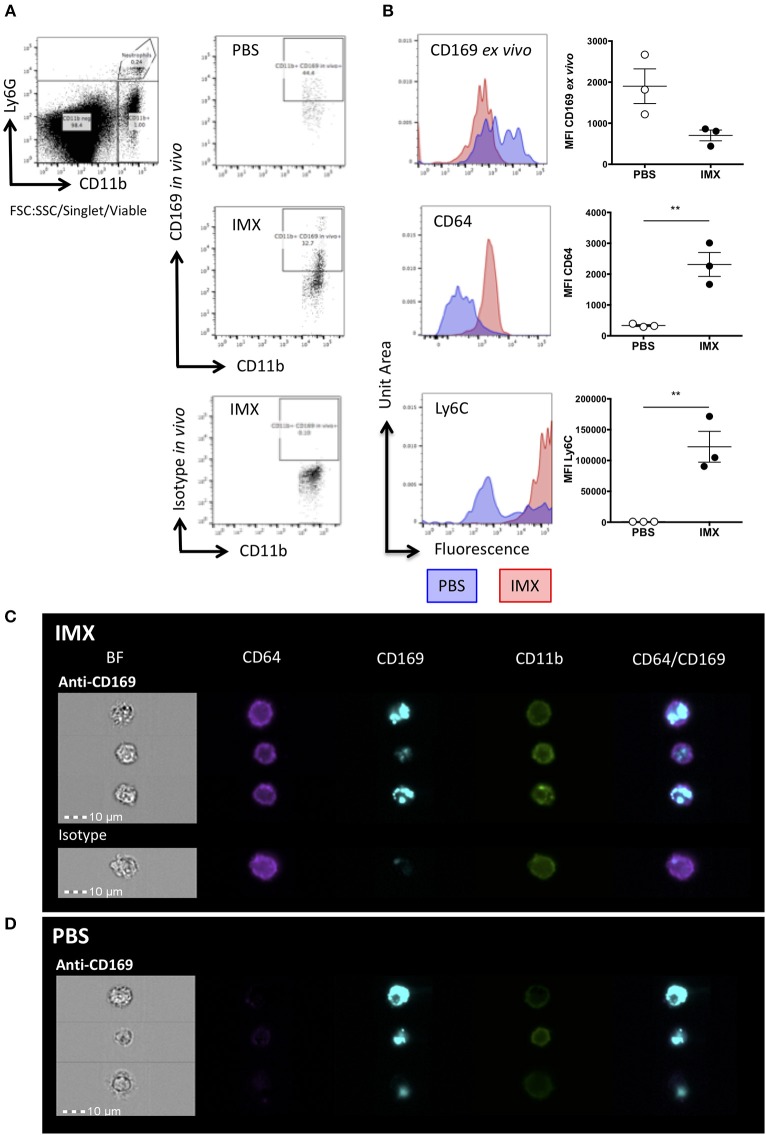
SCS macrophages are taken up by monocytes following immunization with ISCOMATRIX. (A) Representative flow cytometry plots showing in vivo antibody staining with eFluor660 conjugated anti-CD169 prior to treatment with PBS (top) and ISCOMATRIX (middle) or the isotype control antibody (bottom) treatment in the ear pinnae. (B) Representative histograms and MFI (points = individual animals, lines show mean±SEM) of ex vivo PE conjugated anti-CD169 (top); anti-CD64 (middle), and anti-Ly6C (bottom) on cells positive for the in vivo CD169 label. Groups contained 3 animals and data is representative of two independent experiments **P < 0.01. (C) Representative imaging flow cytometry images showing monocytes at 24 h post-immunization with ISCOMATRIX from the lymph nodes of mice following in vivo eFluor660 conjugated anti-CD169 (top) or the isotype control (bottom) labeling. (D) Representative imaging flow cytometry images showing macrophages (CD11b+) at 24 h post-immunization with PBS from the lymph nodes of mice following in vivo eFluor660 conjugated anti-CD169 labeling. The anti-CD169 antibody treated group contained 3 animals, while the isotype control treated group contained 2 animals. IMX = ISCOMATRIX™ adjuvant.